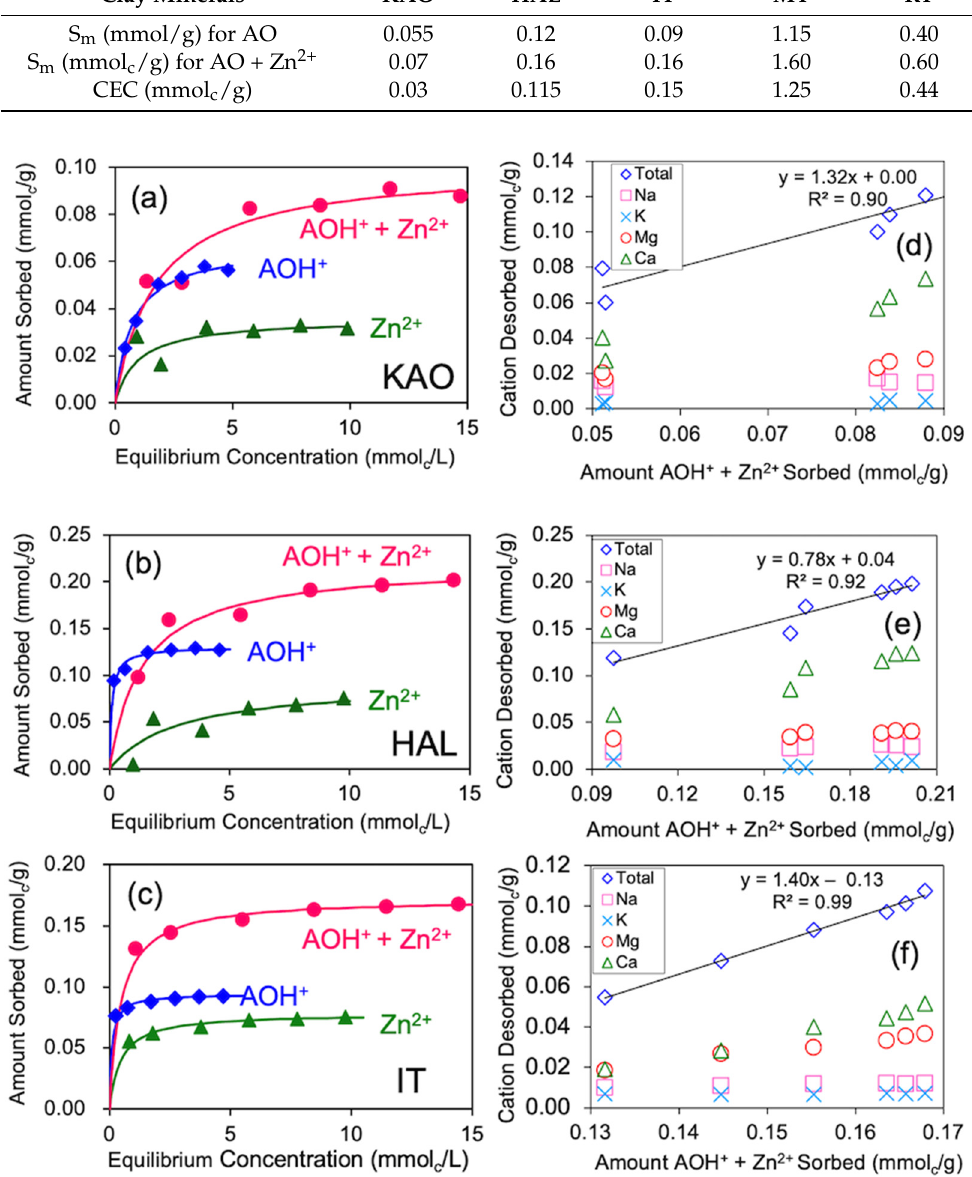
Figure 2. Sorption isotherms of AO on KAO ( a ), HAL ( b ), and IT ( c ); desorption of exchangeable cations from KAO ( d ), HAL ( e ), and IT ( f ) accompanying AO sorption. As the molarity of Zn to AO was 1:1 in solution and Zn has a charge of 2+, the Zn 2+ sorbed and total AO + Zn 2+ sorbed are also plotted in these figures to show the stoichiometric of cation exchange.